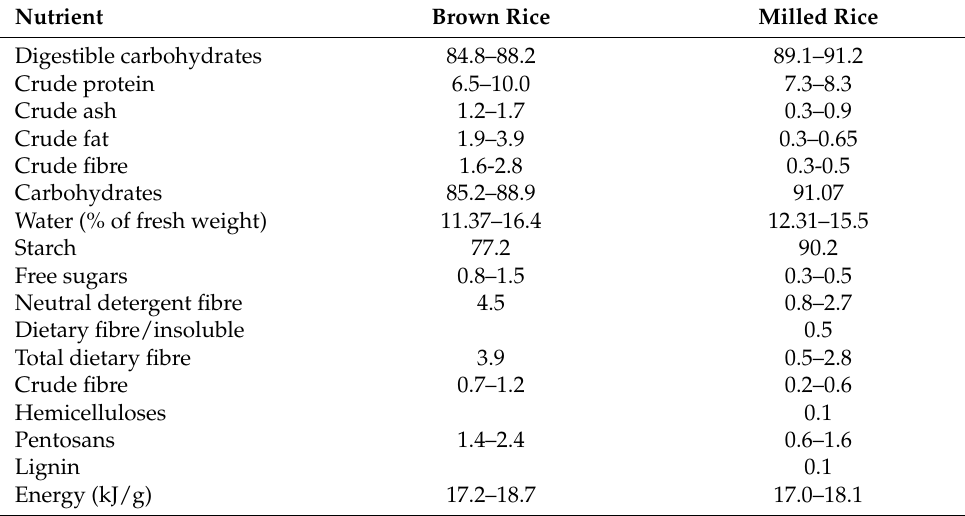
Table 5. Nutritional composition of rice. Modified from